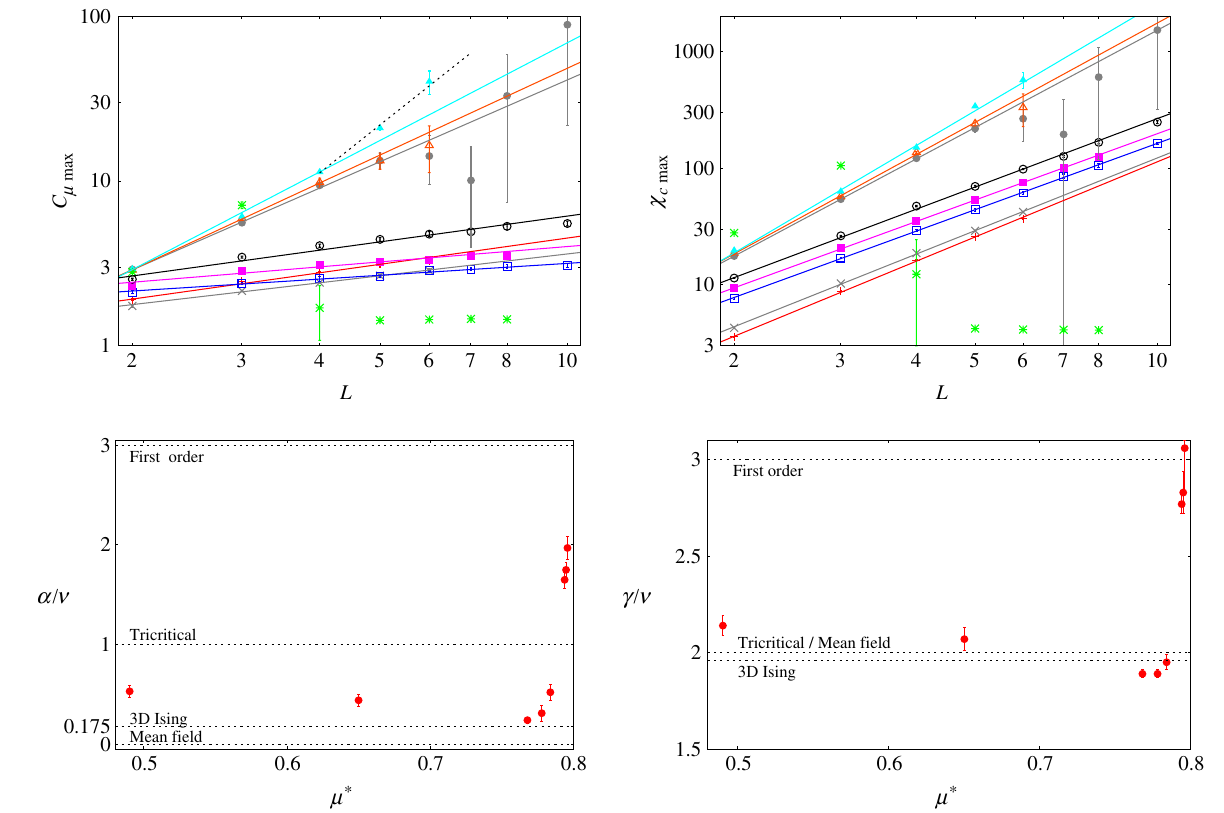
FIG. 9. Top: Finite-size scaling of the maxima of the specific heat C (cid:2) and susceptibility (cid:5) c of the order parameter M c as a function of linear system size L , for (cid:2) (cid:4) ¼ 0 : 490 (+), 0.654 ( (cid:6) ), 0.768 ( h ), 0.778 ( j ), 0.784 ( (cid:7) ), 0.794 ( (cid:10) ), 0.795 ( 4 ), 0.796 ( m ), and 0.801 ( $ ). The error bars are the standard deviation (cid:7) over four independent simulation outcomes. Each solid line is the best fit obtained using Wolfram Mathematica v9.0 [103], including all data points for a given (cid:2) (cid:4) and weighting each data point by 1 =(cid:7) 2 . The dashed line is a guide to the eye for the cubic power law ( / L 3 ) appearing in the first-order regime for L (cid:9) 4 . Bottom: Scaling exponent ratios (cid:3)=(cid:6) and (cid:8)=(cid:6) as a function of (cid:2) (cid:4) . The error bars represent a confidence level of 90% , based on the statistical uncertainty of the data plotted in the top